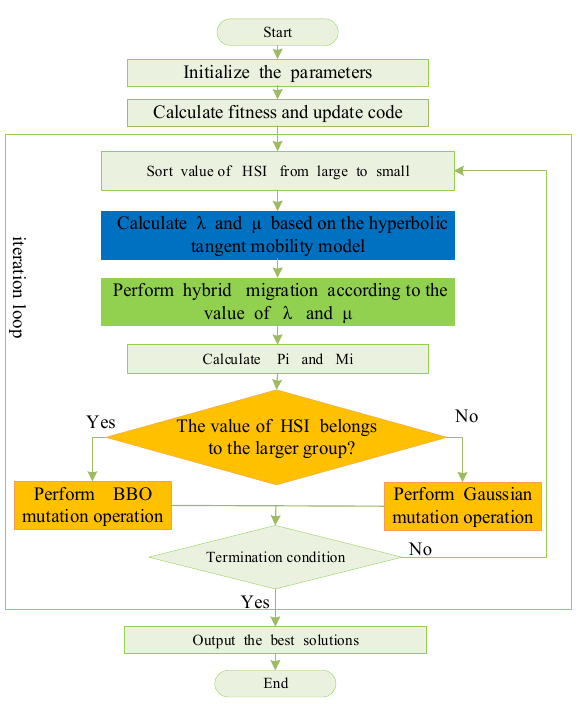
Figure 2. HDBBO algorithm flow chart.